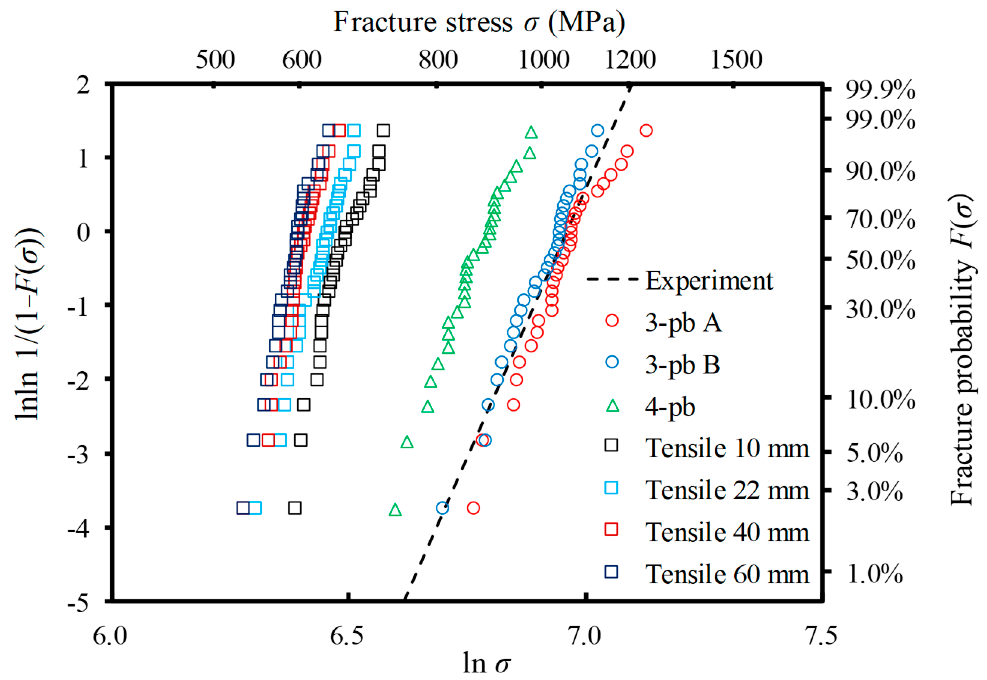
Figure 7. Numerically-obtained Weibull distributions for seven tests. For each test, N = 30 specimens were used. The dashed line is the experimentally-obtained result of the Al 2 O 3 / 30 vol% SiC particle composite ( m = 14.5 and β = 1055 MPa) [16]. Table 3. Weibull parameter m , scale parameter β , and effective volume V eff corresponding to Figure 7.